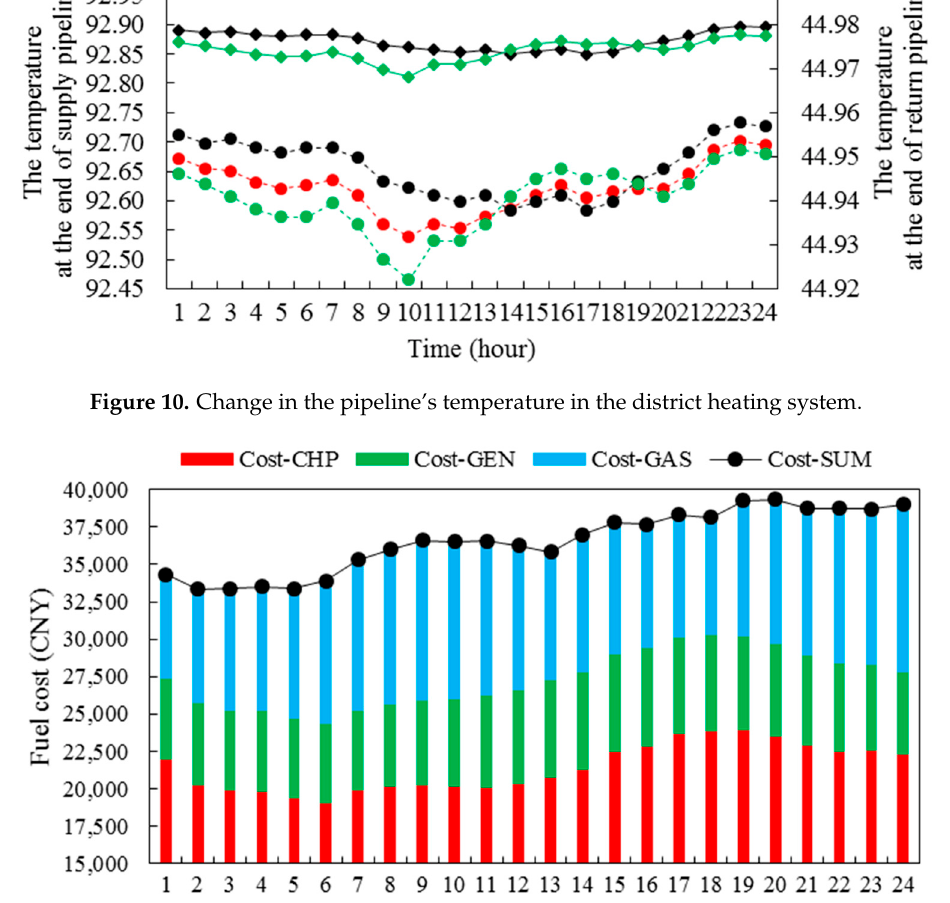
Figure 10. Change in the pipeline’s temperature in the district heating system.